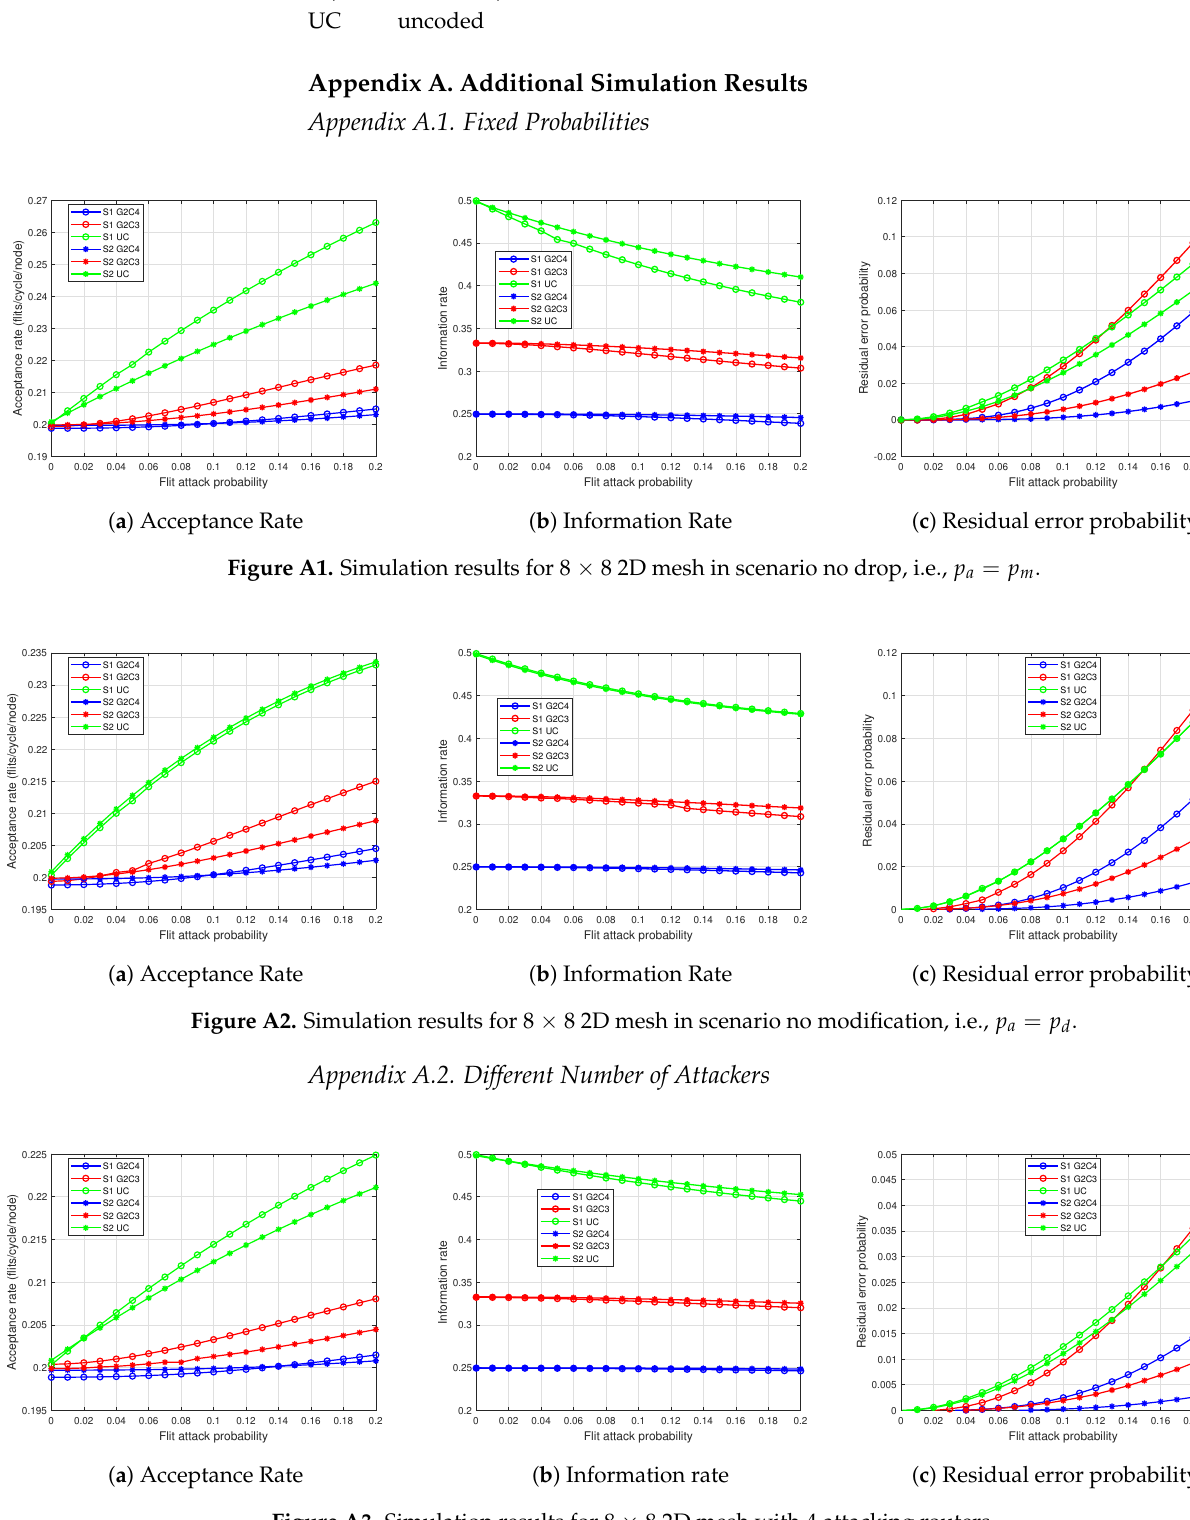
Figure A3. Simulation results for 8 × 8 2D mesh with 4 attacking